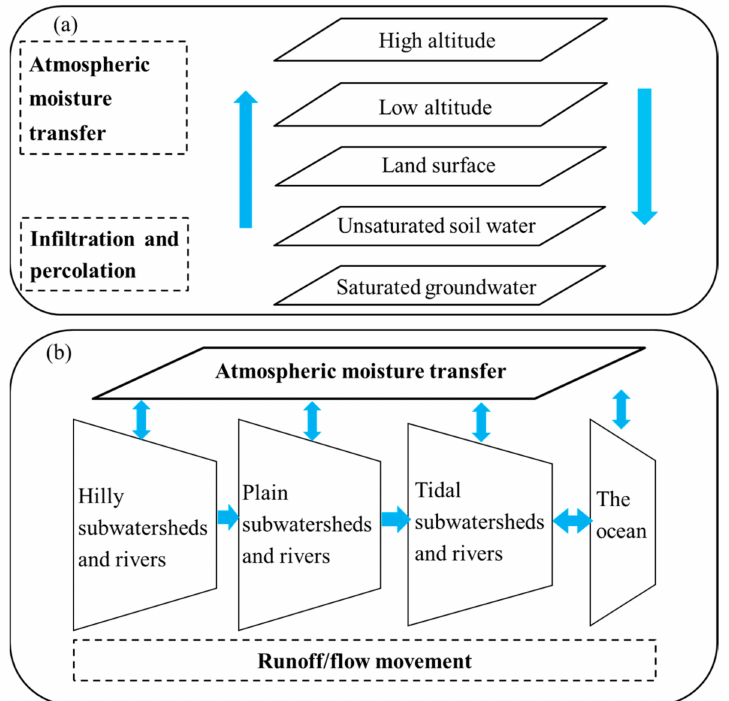
Figure 2. Schematic diagram of the water cycle in ( a ) vertical and ( b ) longitudinal